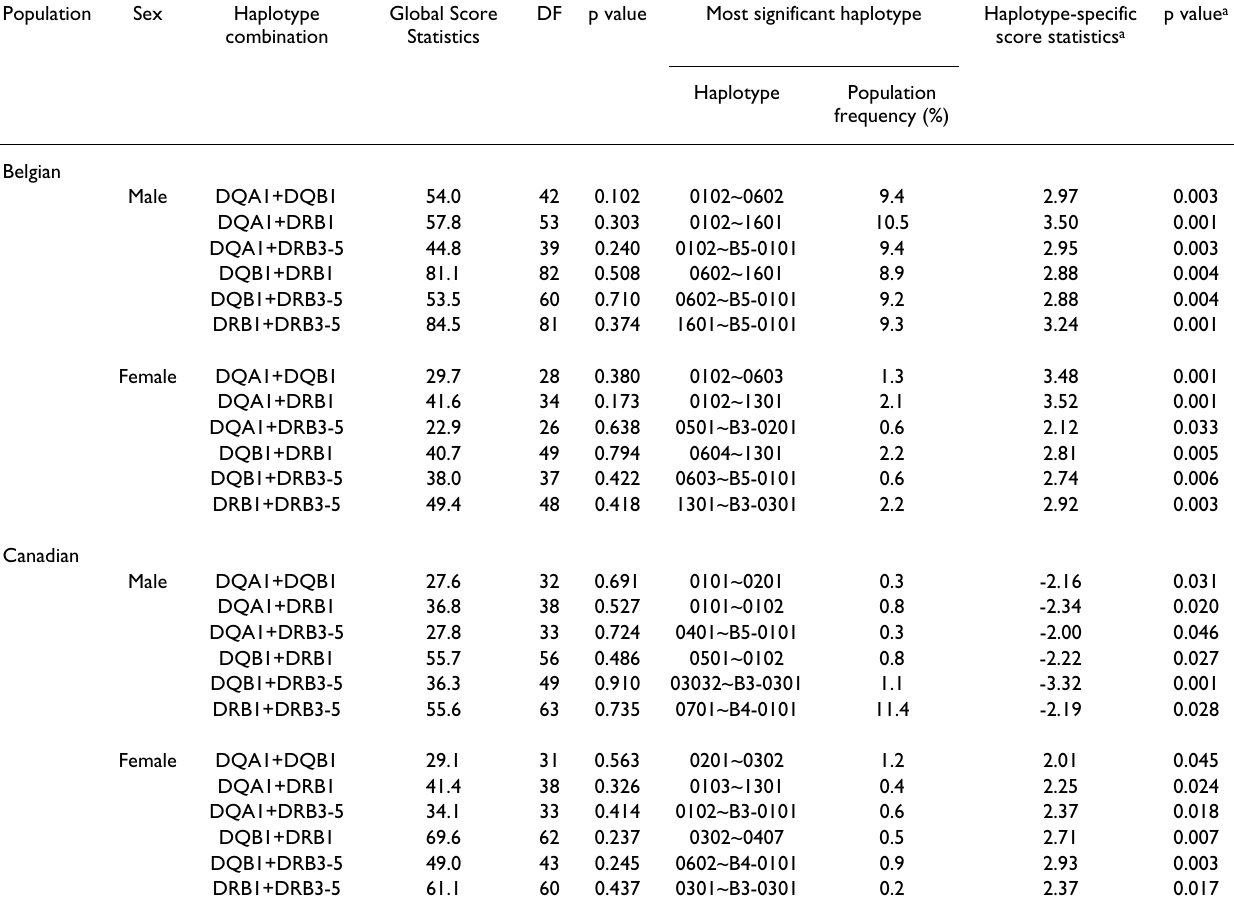
Table 8: Haplotype analyses for two HLA loci combined and stratified by population and sex Population